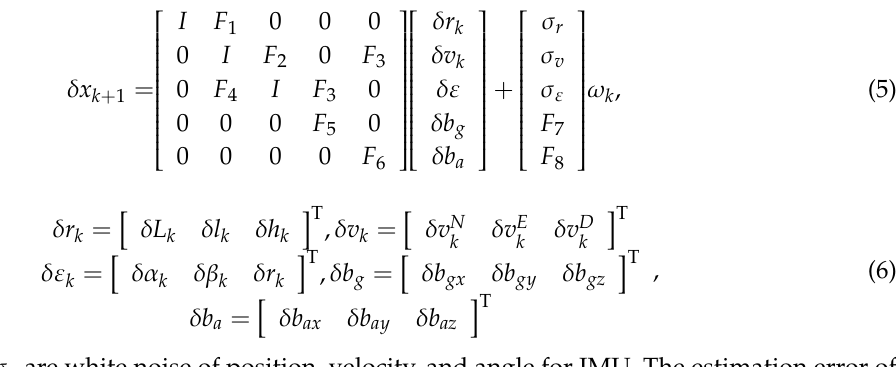
heading angle error. The error model of IMU can be represented by a continuous linear